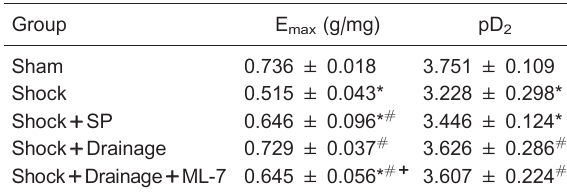
Table 1. Influence of mesenteric lymph drainage on E max and pD 2 of vascular response to norepinephrine in rats following hemorrhagic shock.